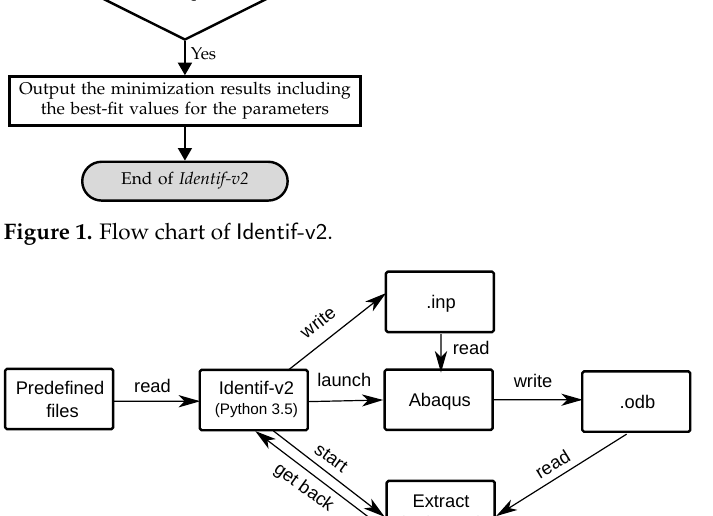
Figure 2. Data flow diagram of the proposed inverse identification